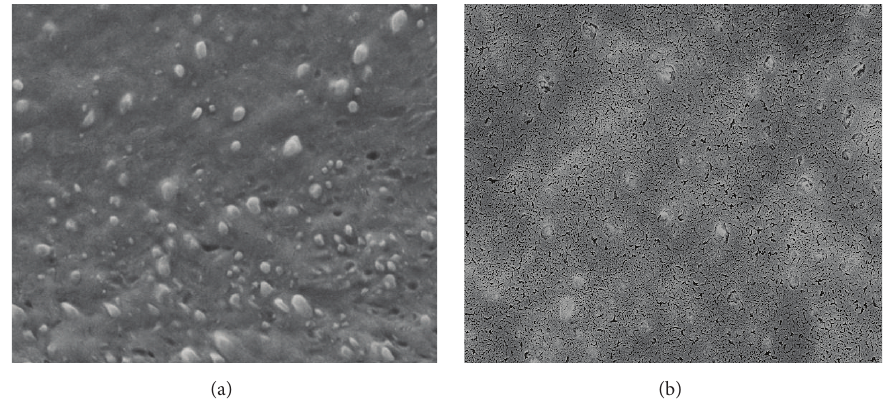
Figure 10: SEM micrographs: (a) [MG49-25.0 wt.% LiClO 4 ]:[8.0 wt.% HNO 3 -THF/TiO 2 -SiO 2 ] and (b) [MG49-25.0 wt.% LiClO 4 ]:[8.0 wt.% ClHNO 2 -THF/TiO 2 -SiO 2 ] polymer electrolytes.